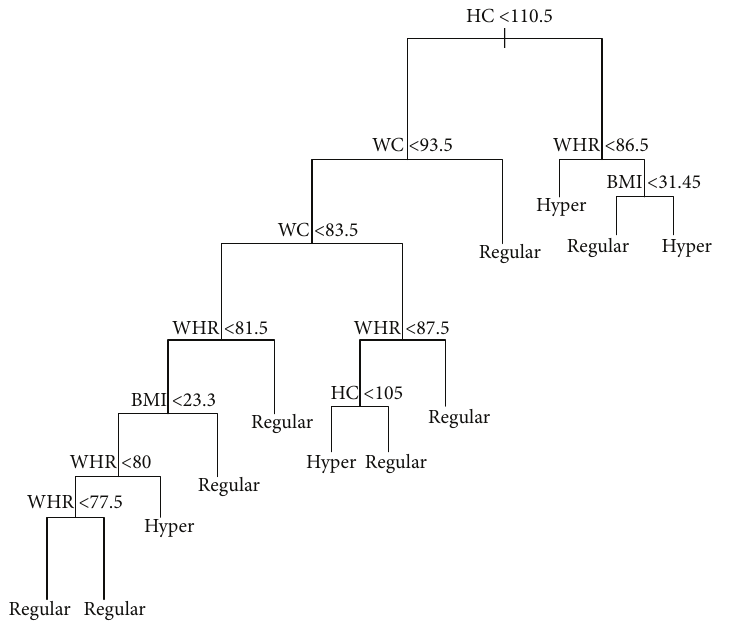
Figure 2: Best model for men. Notice that the endpoint for men is greater than 140 mmHg